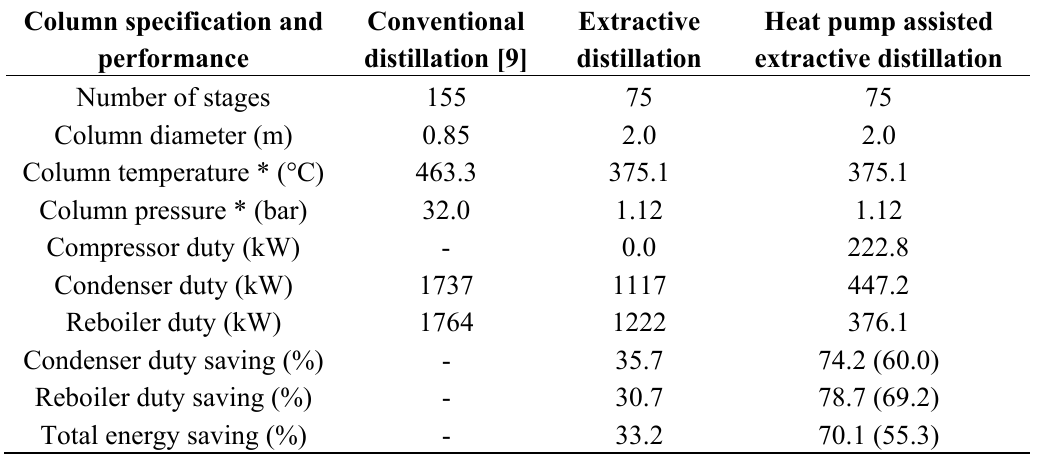
Table 3. Comparison of different distillation approaches for ultra-purification of Zr-Hf tetrachlorides. Column specification and Conventional Extractive Heat pump assisted performance distillation [9] distillation extractive distillation Number of stages 155 75 Column diameter (m) 0.85 Column temperature * (°C) Column pressure * (bar) Compressor duty (kW) Condenser duty (kW) Reboiler duty (kW) Condenser duty saving (%) Reboiler duty saving (%) Total energy saving